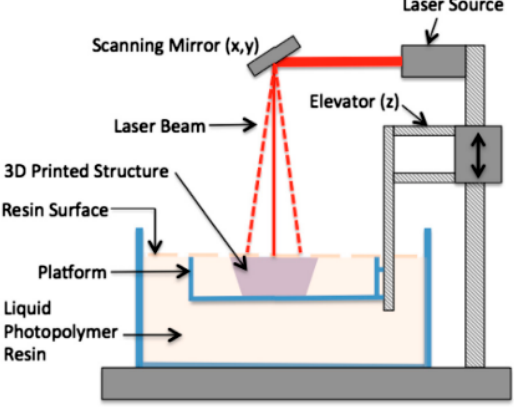
Figure 16. Components of a stereolithography